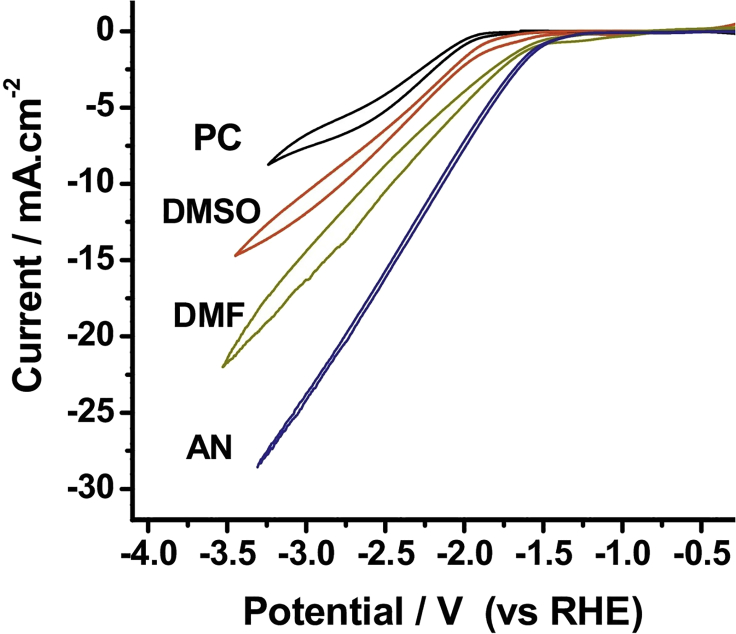
Cyclic Voltammograms Recorded in 0.1 M Bu4NClO4 in Various Solvents at Au Cathode versus reversible hydrogen electrode (RHE) REReproduced with permission from (Shi et al., 2017).